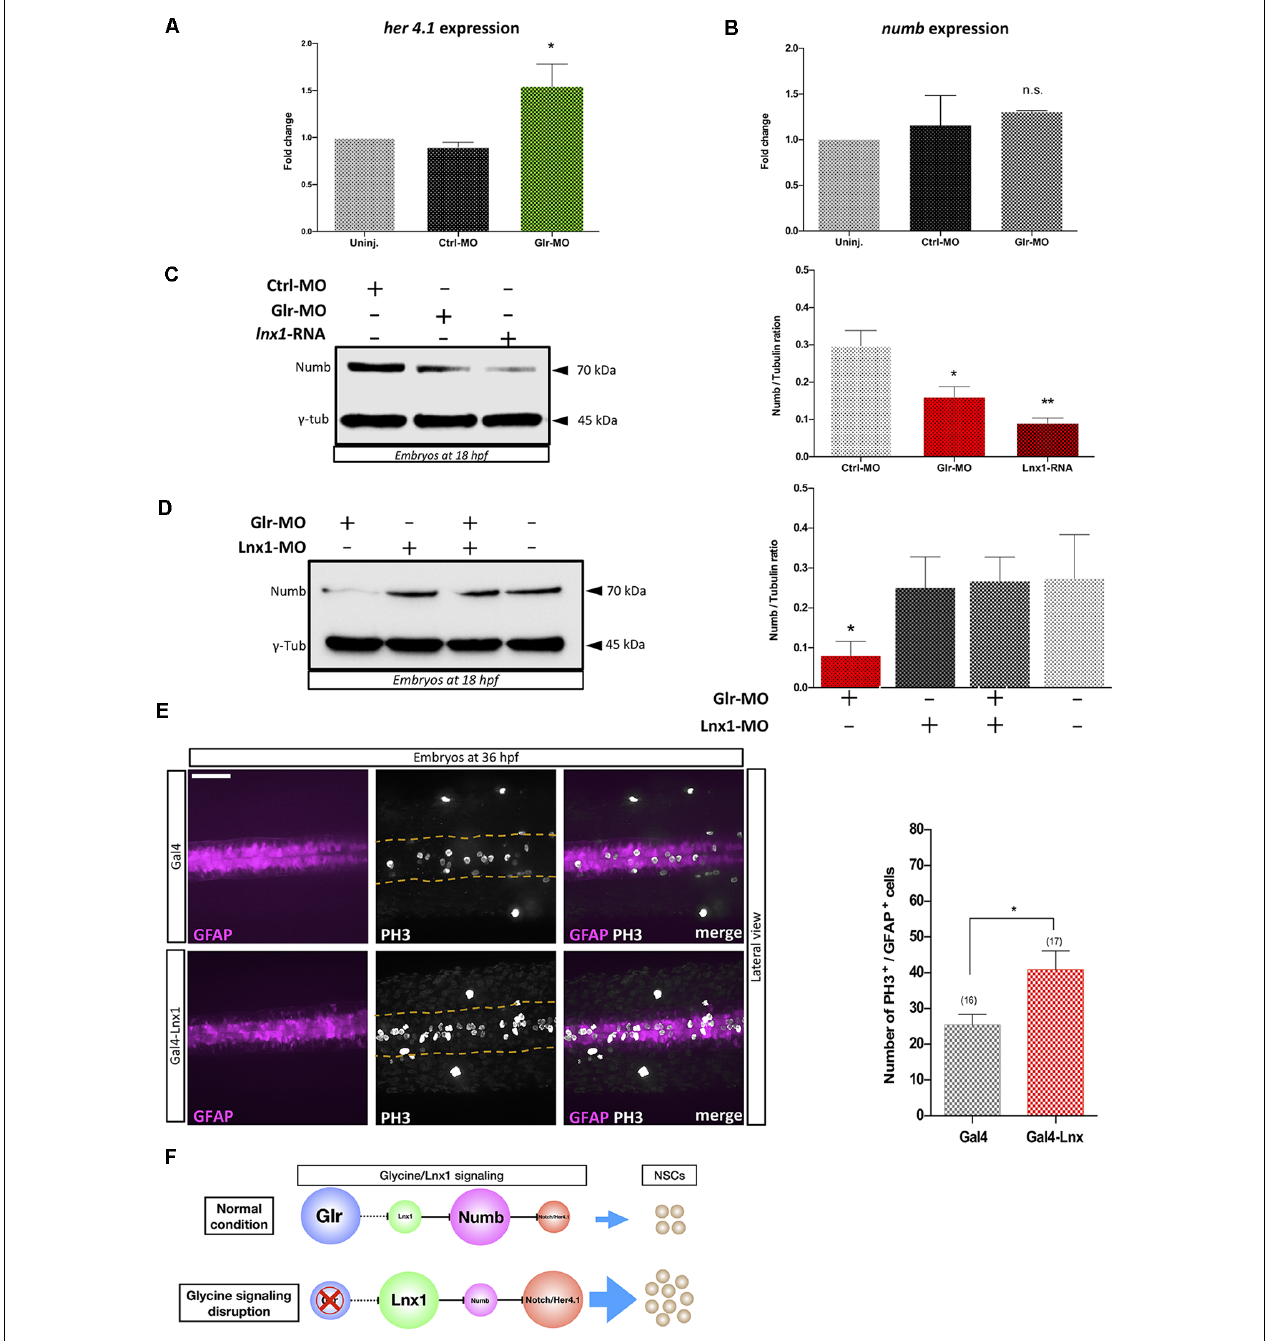
FIGURE 2 | Glycine signaling modulates Notch activity via lnx1 expression and promotes NSCs proliferation. Quantification of her4.1 mRNA (A) and numb mRNA (B) level into sorted GFAP + -NSC by RT-qPCR revealed a significant increase of her4.1 expression upon disruption of glycine signaling by Glr-MO compared with uninjected and Ctrl-MO conditions. However, no significant changing of numb expression. One-way ANOVA statistical analysis was performed [ n = 3, ∗ p -value < 0.05, not significant (n.s.)]. (C) Expression of Numb protein was revealed by western bolt at 18 hpf showing a significant degradation of numb protein upon disruption of glycine signaling by Glr-MO and overexpression of lnx1 by lnx1 mRNA injection compared with Ctrl-MO injections which were used as control condition. However, Co-injection of Glr-MO and lnx1 -MO (D) rescued Numb protein degradation. One-way ANOVA statistical analysis was performed ( n = 3, ∗ p -value < 0.05, ∗∗ p -value < 0.01). (E) Proliferation of GFAP + -NSCs (pink) in spinal cord by PH3 immunostaining (white) into tg(GFAP:Gal4, UAS:RED; top panel), and tg(GFAP:Gal4, UAS, lnx1 , UAS:RED; bottom panel) revealed a significant increase of GFAP + -NSCs proliferation in lnx1 overexpression embryos (right panel). One-way ANOVA statistical analysis was performed ( n = 17, ∗∗ p -value < 0.0001, scale bar, 250 µ m). (F) The schematic model of regulation of Notch activity by glycine/ lnx1 signaling into zebrafish NSCs during early development.